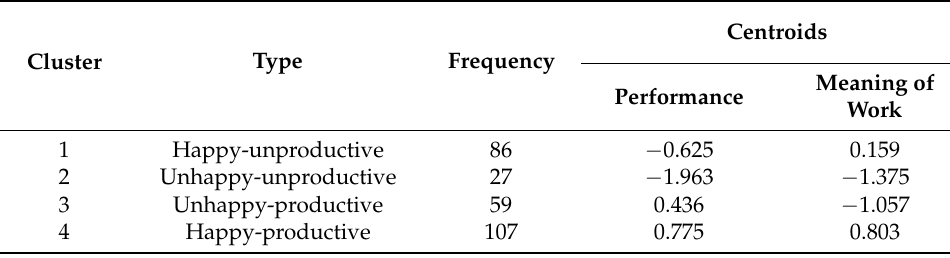
Table 3. Four-cluster solution, cluster standardized means, and group-sizes between Meaning of Work and Job Performance (Study 2; N = 281).